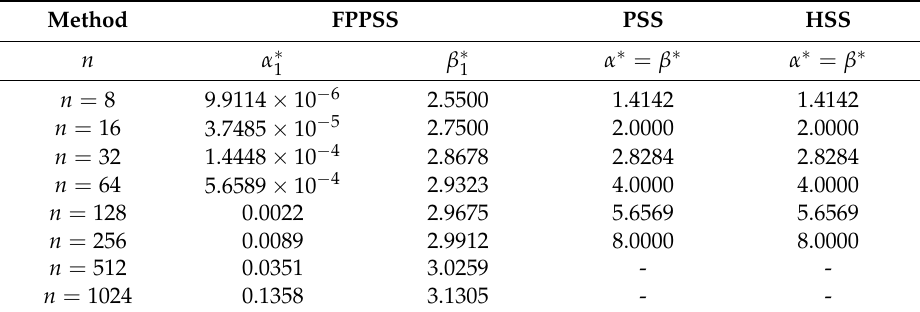
Table 4. The practical optimal value for FPPSS, PSS, and HSS for Example